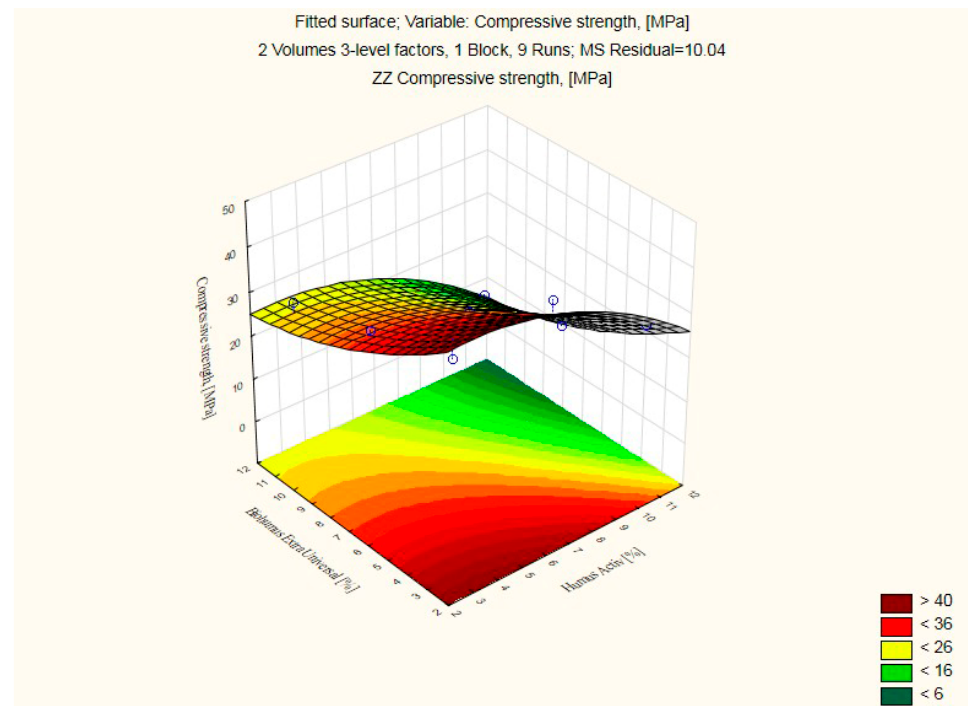
Figure 10. Response fitting surface plot for compressive strength of modified silicate products with Humus Activ and Biohumus Extra Universal.